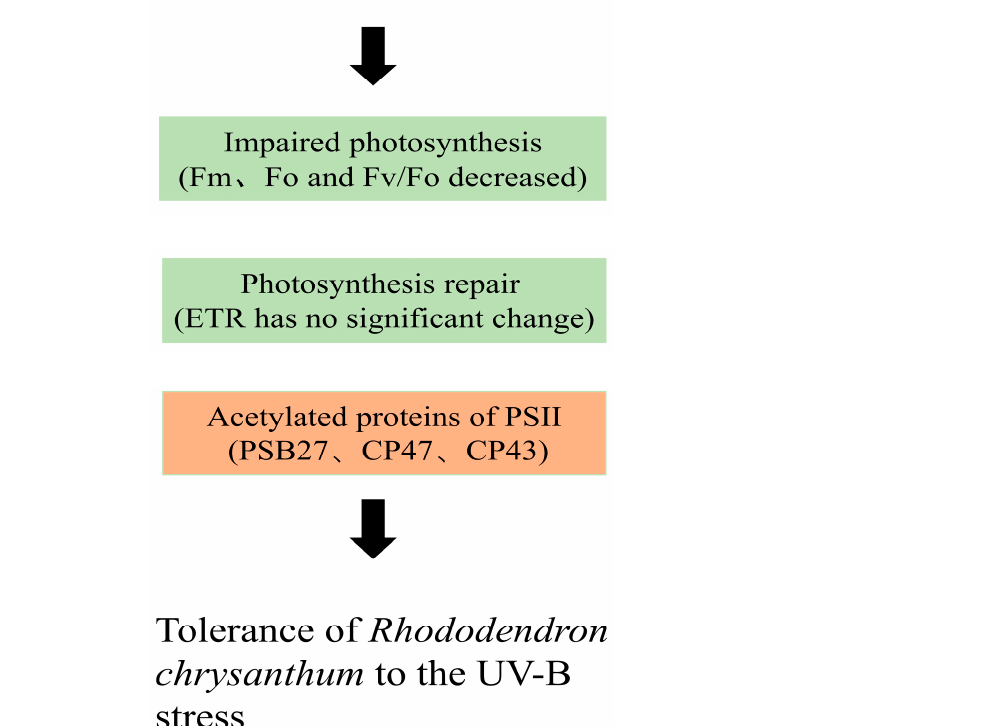
Figure 8. Schematic overview of acetylated proteomic strategy against UV-B stress in Rhododen- dron chrysanthum . Photosynthetic adaptation (green box) and PSII acetylated protein (yellow box) are